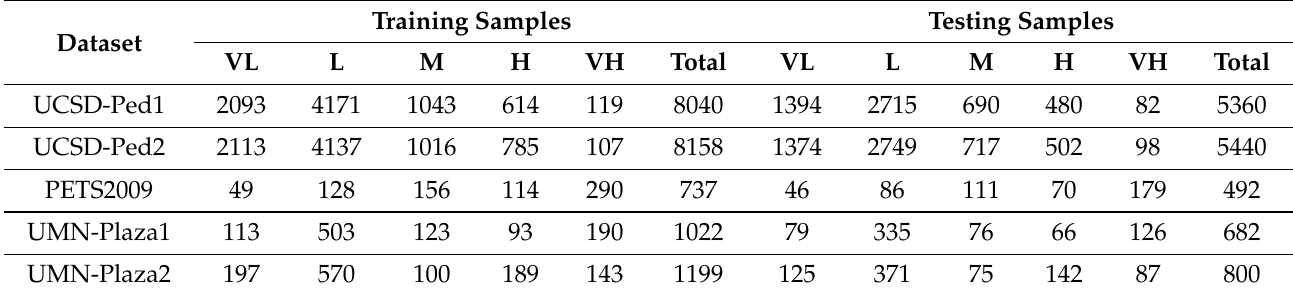
Table 4. Details of datasets’ splits for training and testing.